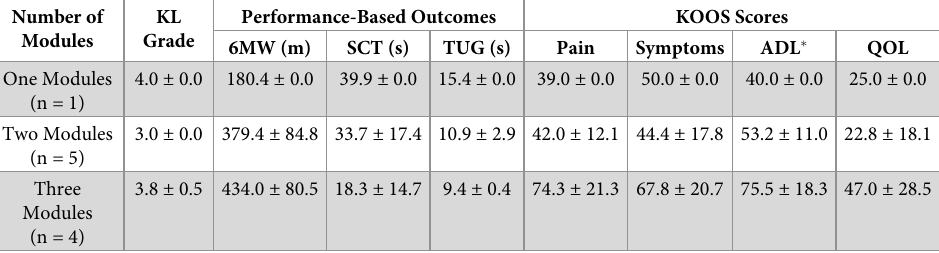
Table 8. Knee osteoarthritis clinical assessments by module group.